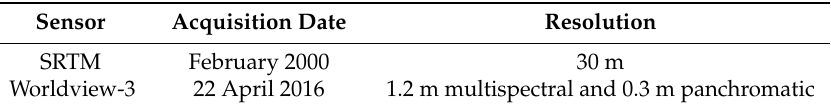
Table 3. Product Specifications of Digital Elevation Model (DEM) product and optical imagery used in the analysis.